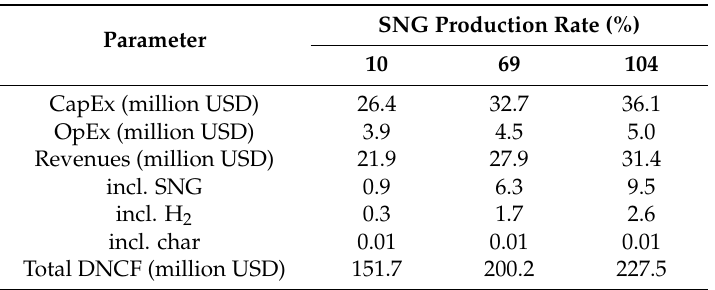
Table 5. Economic analysis results for different SNG production rates.